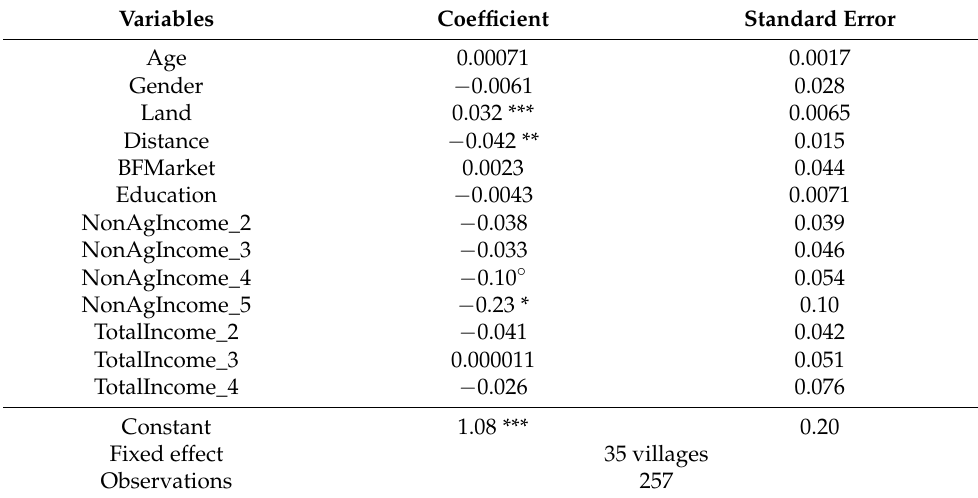
Table 2. Model results explaining factors that affected farmers’ crop